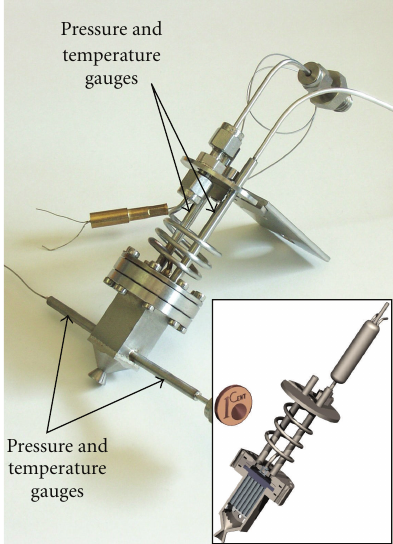
Figure 14: Laboratory model of the monopropellant thruster and a cross-section showing the internal assembly with the